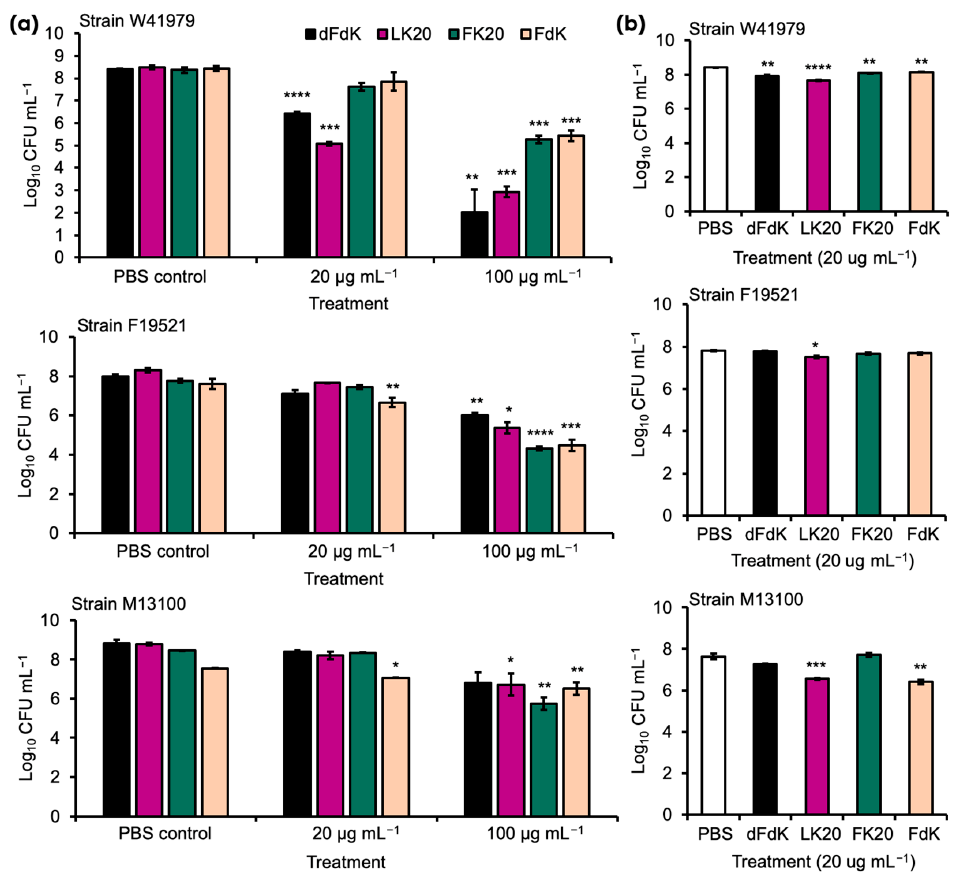
Figure 2. Random peptide mixtures (RPMs) effectively kill A. baumannii in vitro . Overnight stationary phase cultures of A. baumannii strains W41979, F19521, and M13100 were diluted to 10 7 – 10 8 CFU mL − 1 before exposure to indicated concentrations of RPMs for 1 h by incubating at 37 °C rotating on a rotary drum ( a ) or under static conditions ( b ). The extent of bacterial killing was determined by colony forming unit (CFU) after serial dilution. Error bars represent SD for n = 3 of a typical experiment performed independently three times. Significance was determined with Student’s t -test. * p < 0.05, ** p < 0.01, *** p < 0.001, and **** p < 0.0001 significance cmpared to respective phosphate buffered saline (PBS) control; data without symbols are not statistically significant.